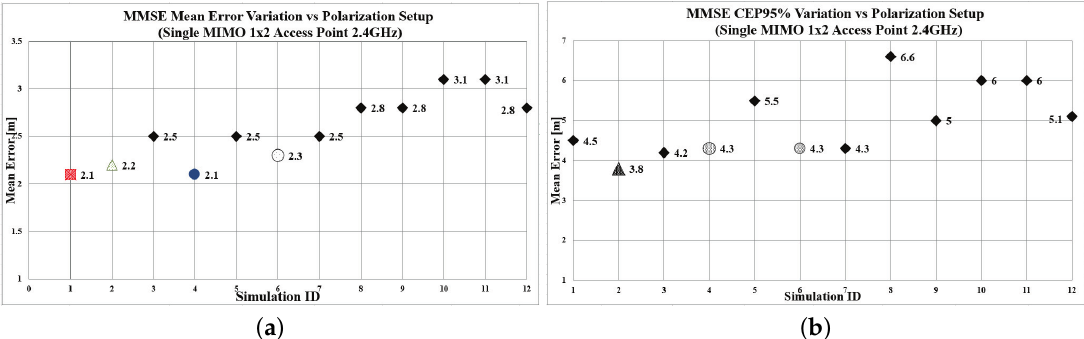
Figure 7. MMSE algorithm performance. ( a ) Mean error per polarization Scenario; ( b ) CEP95 per polarization Scenario.